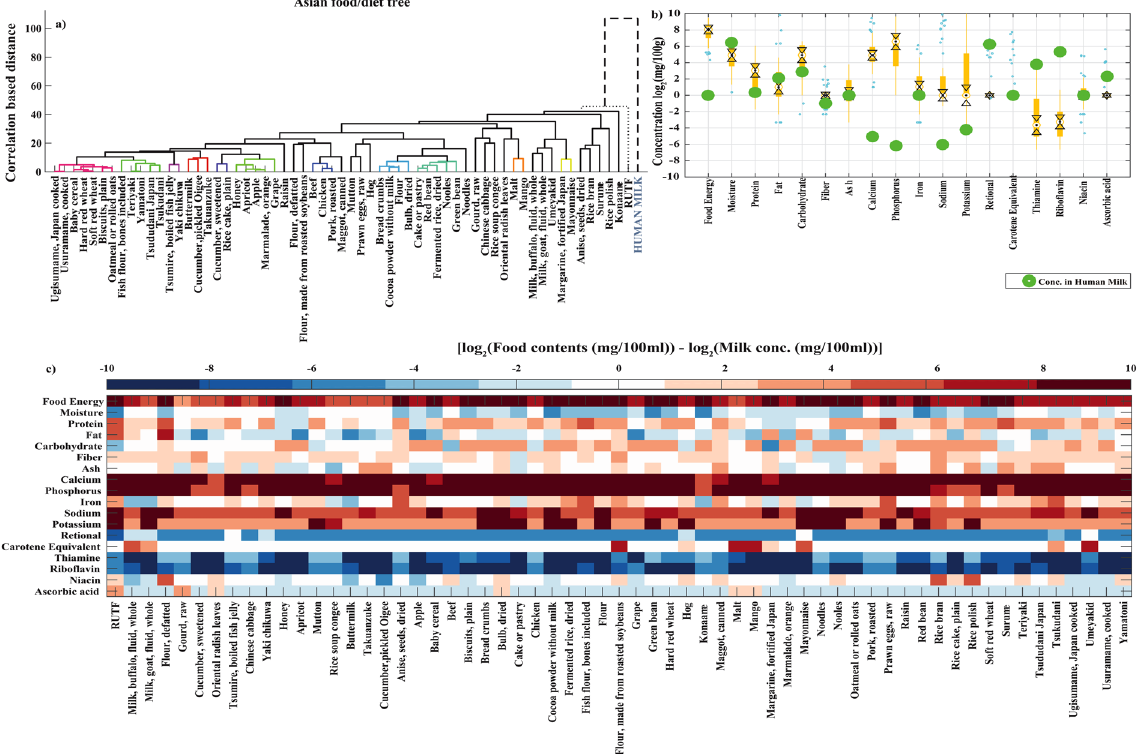
Figure 1. ( a ) Food tree of common and traditional Asian foods/diets. Each branch represent CBDM ( γ ) scaled between [0–100]. Cluster of similar foods with δ < 10 are color coded. Human milk or standard RUTF is represented as dotted lines. ( b ) Boxplot showing log of total dietary contents expressed in mg/100 g of foods. Black dot represents the median and cyan dots are the outliers. The concentration of the constituents available in human milk is marked with green